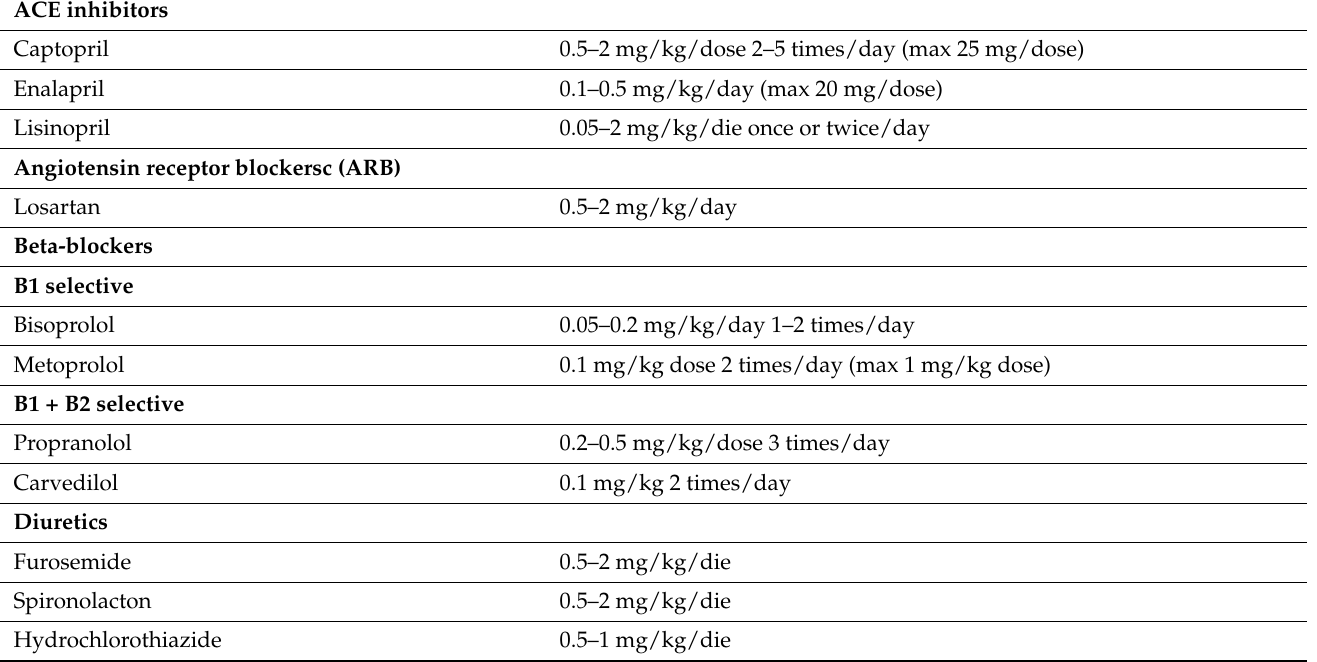
Table 2. Summary of commonly used pediatric HF drugs and